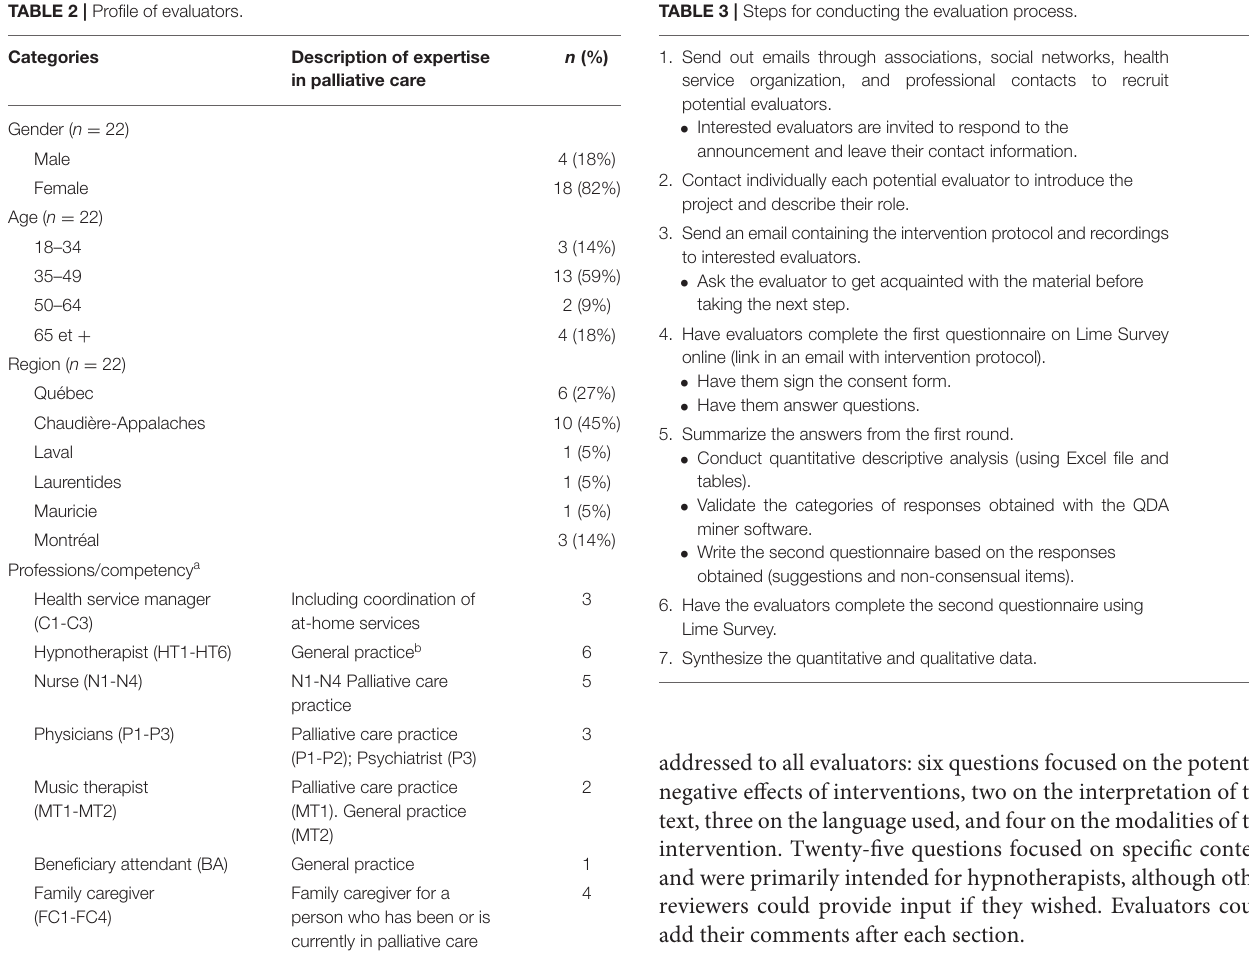
TABLE 2 | Profile of evaluators. TABLE 3 | Steps for conducting the evaluation